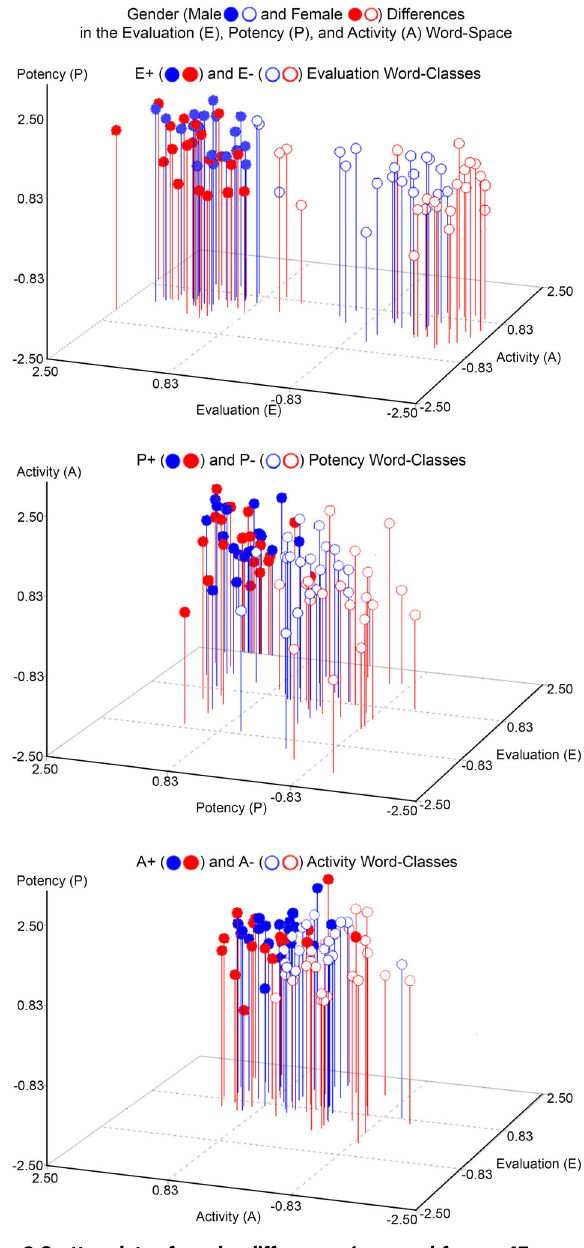
Fig. 2 Scatter plots of gender differences (averaged for n = 47 participants in each gender) in the three-dimensional EPA word-space.